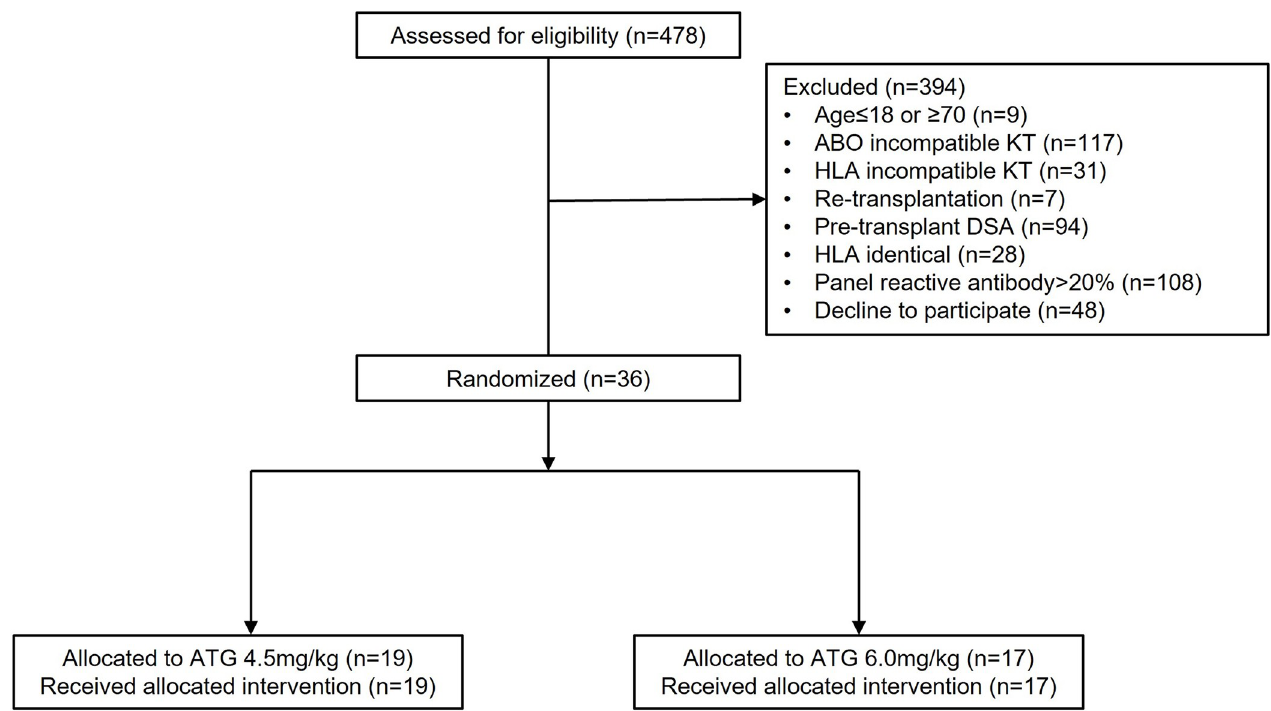
Fig 1. Flow diagram of enrollment, randomization, follow-up, and analysis. ATG, anti-thymocyte globulin; KT, kidney transplantation.